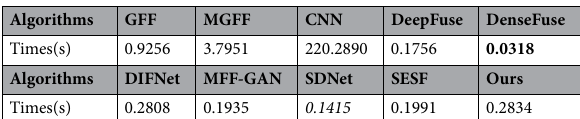
Algorithms GFF MGFF CNN DeepFuse DenseFuse Times(s) Algorithms